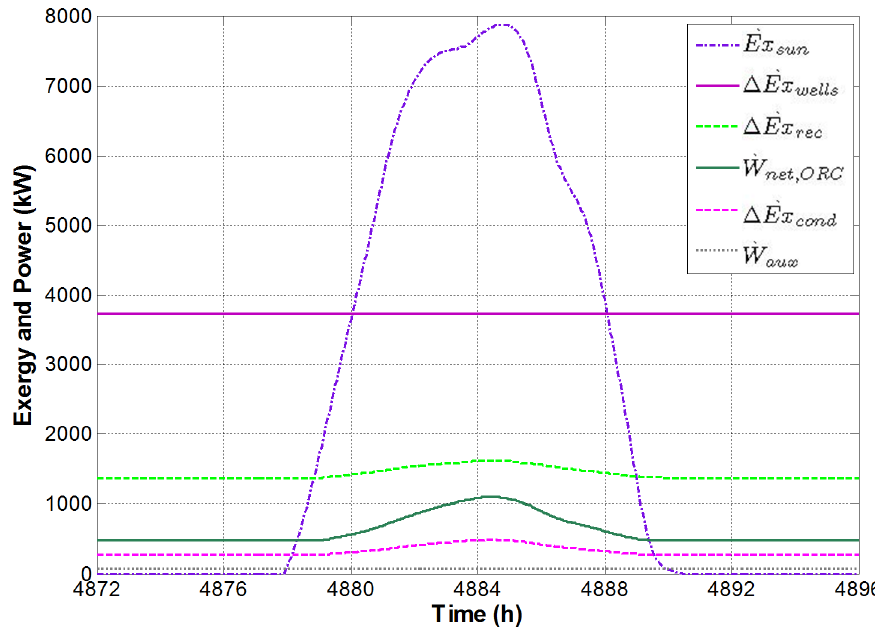
Figure 7. Exergy flows in a summer day.